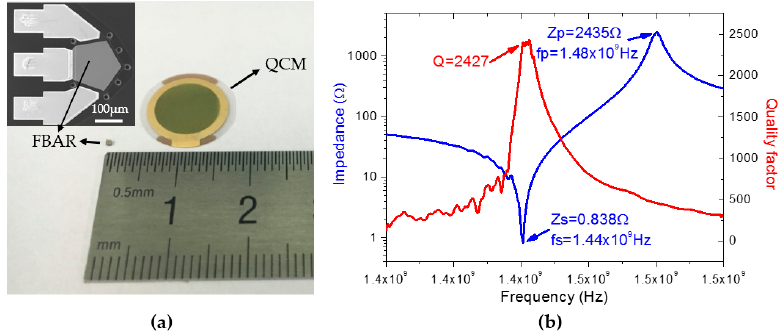
Figure 3. FBAR characterization. ( a ) A comparison of the size between FBAR and quartz crystal microbalance (QCM). The top-left inset shows the top-view scanning electron microscopy (SEM) image of FBAR; ( b ) magnitude of impedance and Q value over frequency.